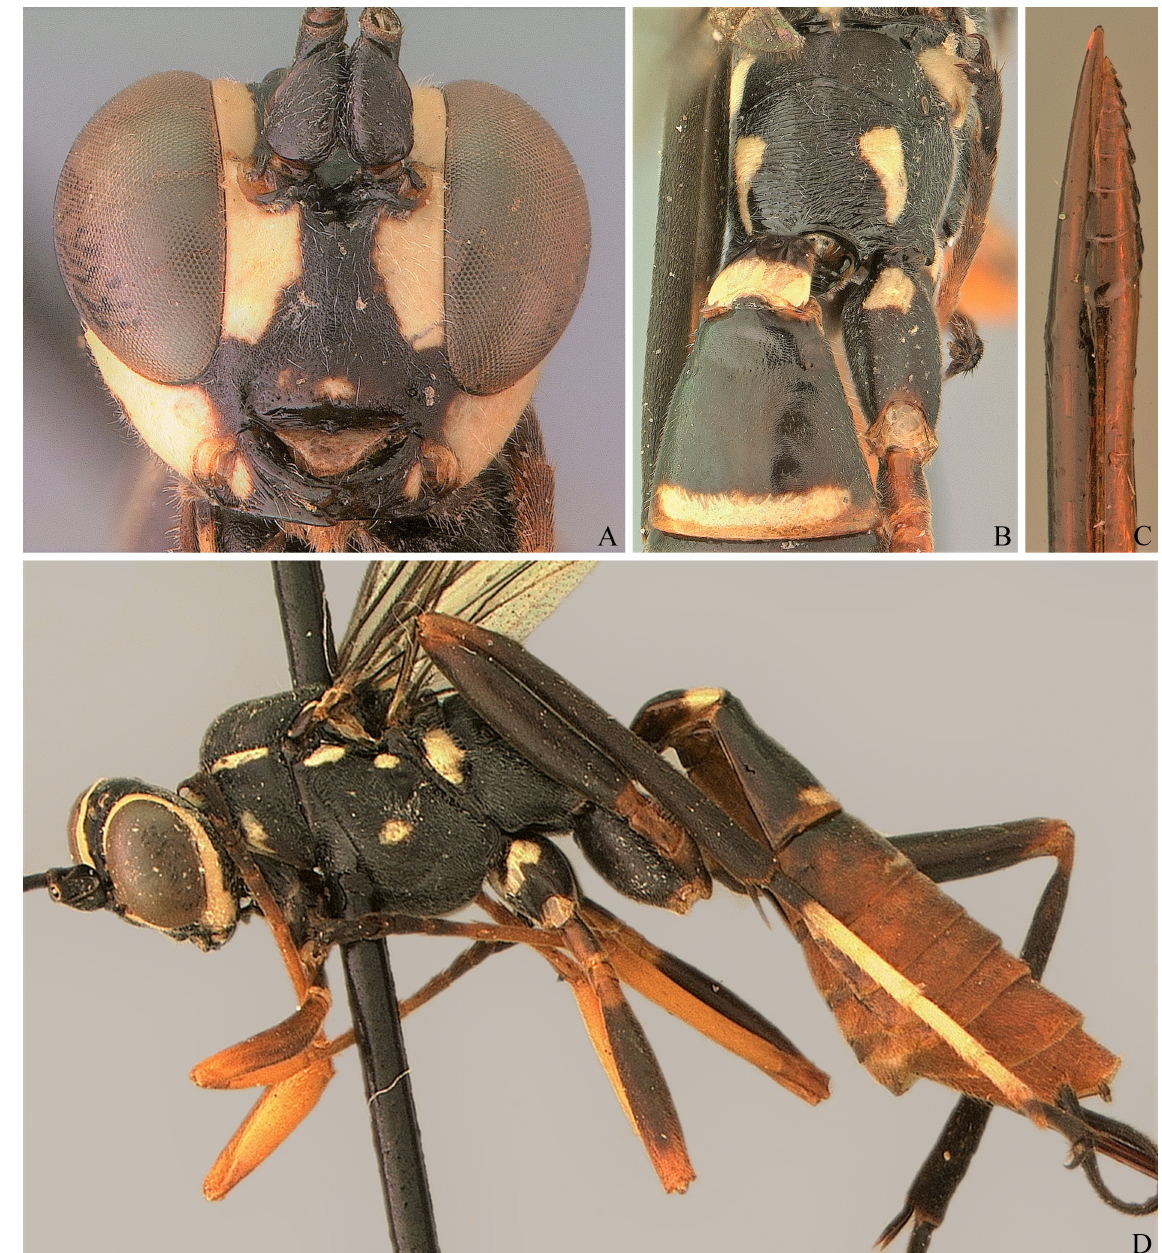
Fig. 6. Distictus asterios sp. nov., holotype (USUC), ♀. A . Head, frontal view. B . Propodeum + first two tergites, dorso-lateral view. C . Apex of ovipositor, left side. D